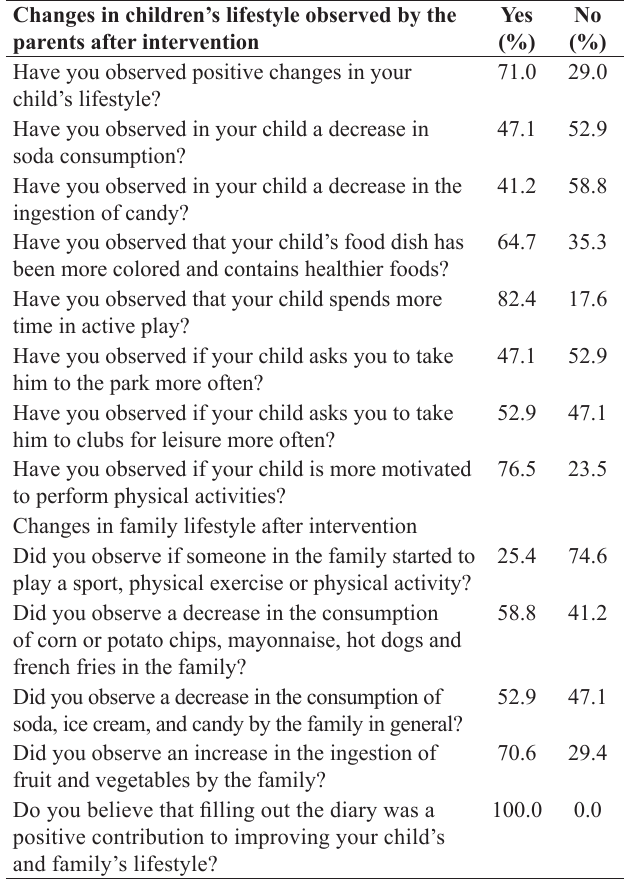
Table 3. Changes in children’s lifestyle as reported by their